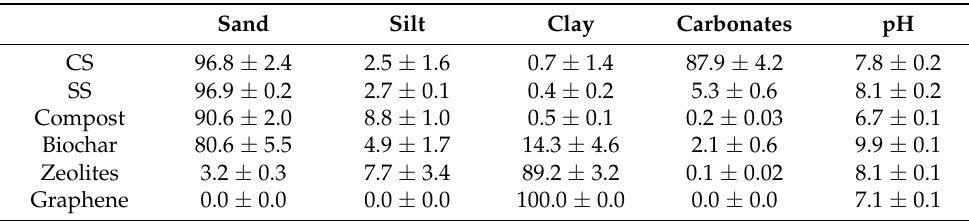
Table 1. Grain size distribution, carbonates content expressed in percentage over dry weight, and pH for the CS and SS soils, and for the four improvers. Standard deviation from triplicate samples is also reported.